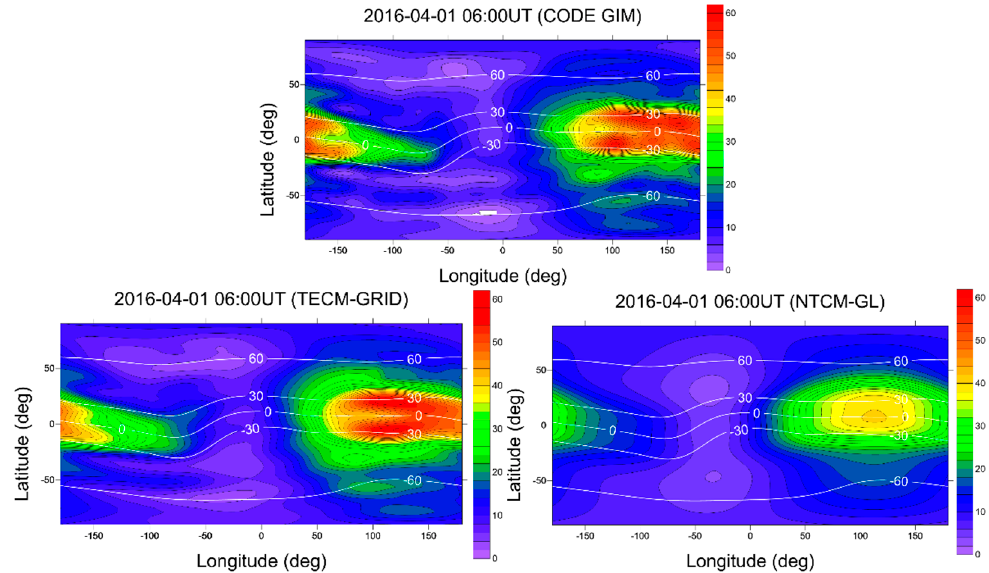
Figure 9. Comparison of TECM-GRID and NTCM-GL with the CODE GIM (1 April 2016). Remote Sens. 2019 , 11 , x FOR PEER REVIEW